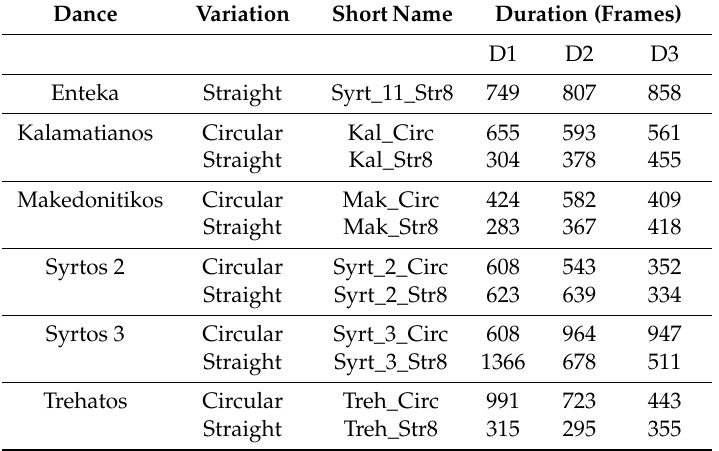
Table 3. List of available dances and their variations as well as their duration, depending on the dancer.